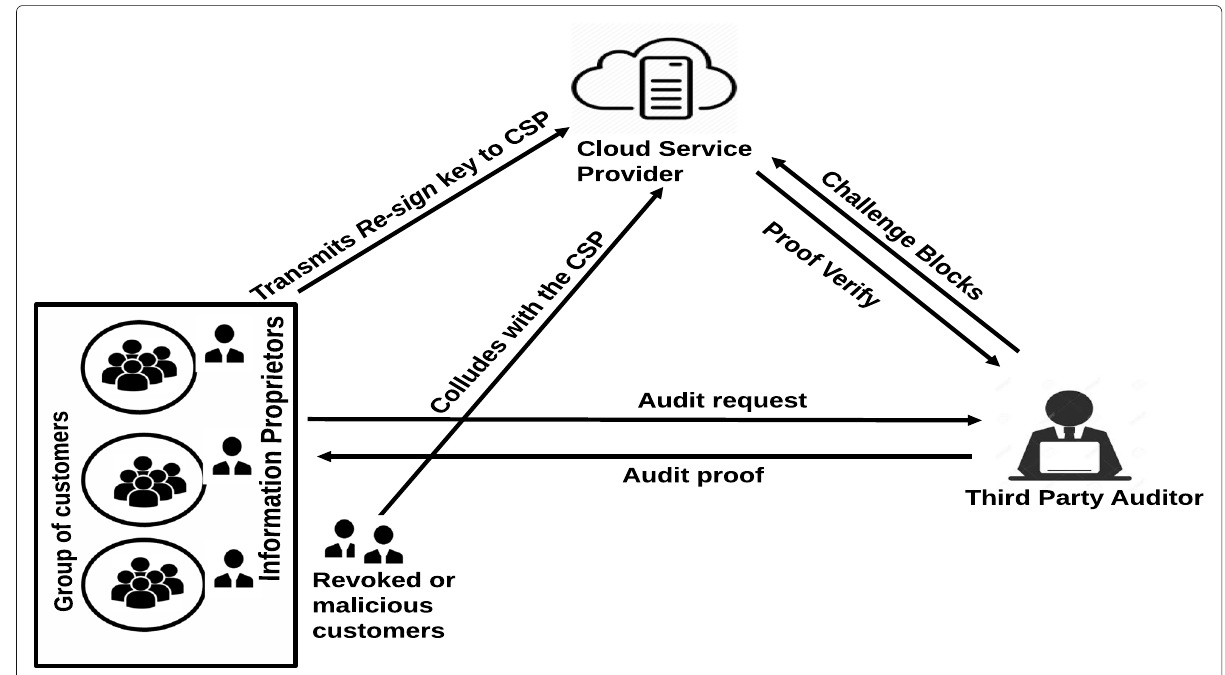
Fig. 2 Adversary model